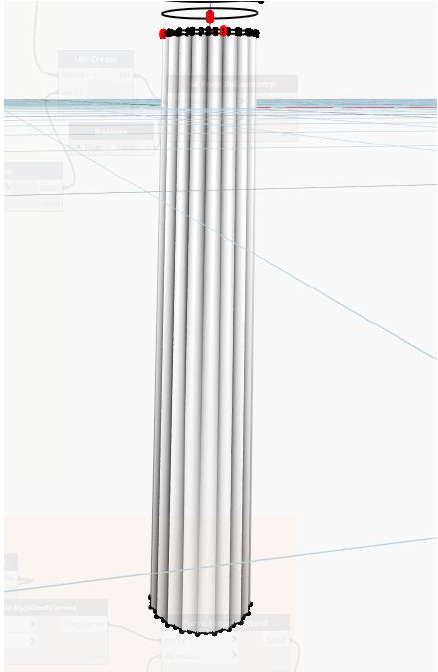
Figure 7. Representation of column shaft in Dynamo. (source: